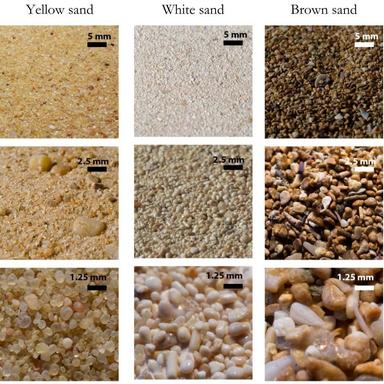
Macro photos with 3 zoom factors for the 3 types of sand.